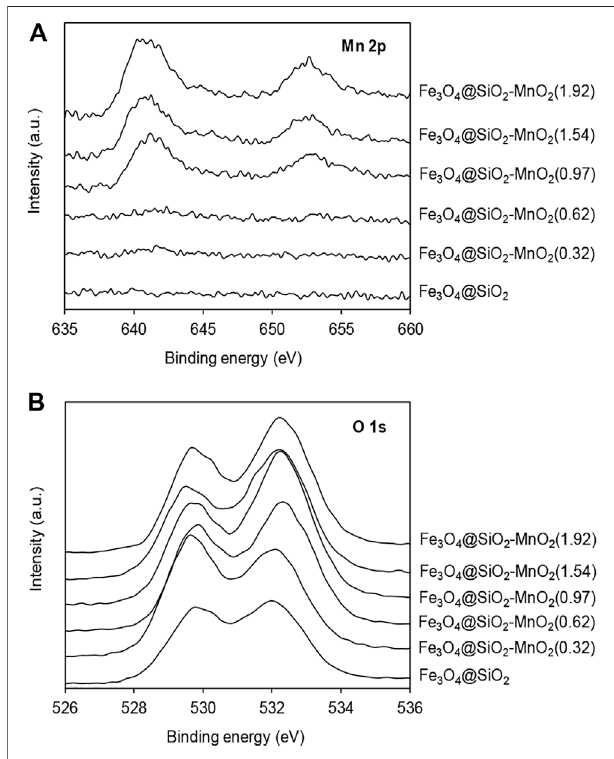
FIGURE 5 | XPS spectra of Fe 3 O 4 @SiO 2 and Fe 3 O 4 @SiO 2 -MnO 2 in (A) the Mn 2p and (B) the O 1s